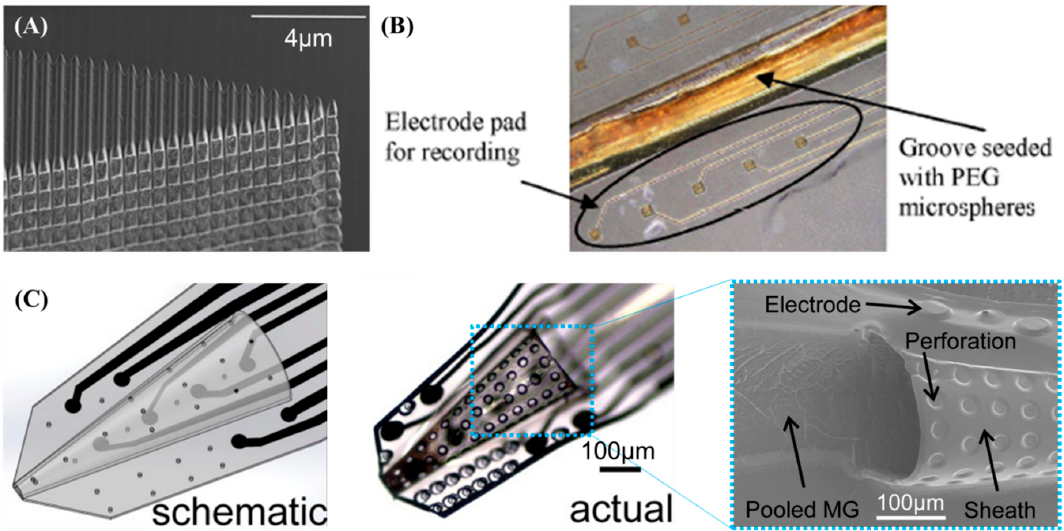
Figure 5. Nanostructured and sheath probes: ( A ) probe having a nano-groove for reduced immune reaction (Reproduced from [186] with permission by John Wiley & Sons, 2017); ( B ) probe having a micro-groove to deliver bioactive molecules (reprinted from [183] with permission from IEEE, © 2006); ( C ) probe having a truncated cone sheath with perforations and a matrigel coating (reproduced from [192] with permission by John Wiley & Sons, 2015).